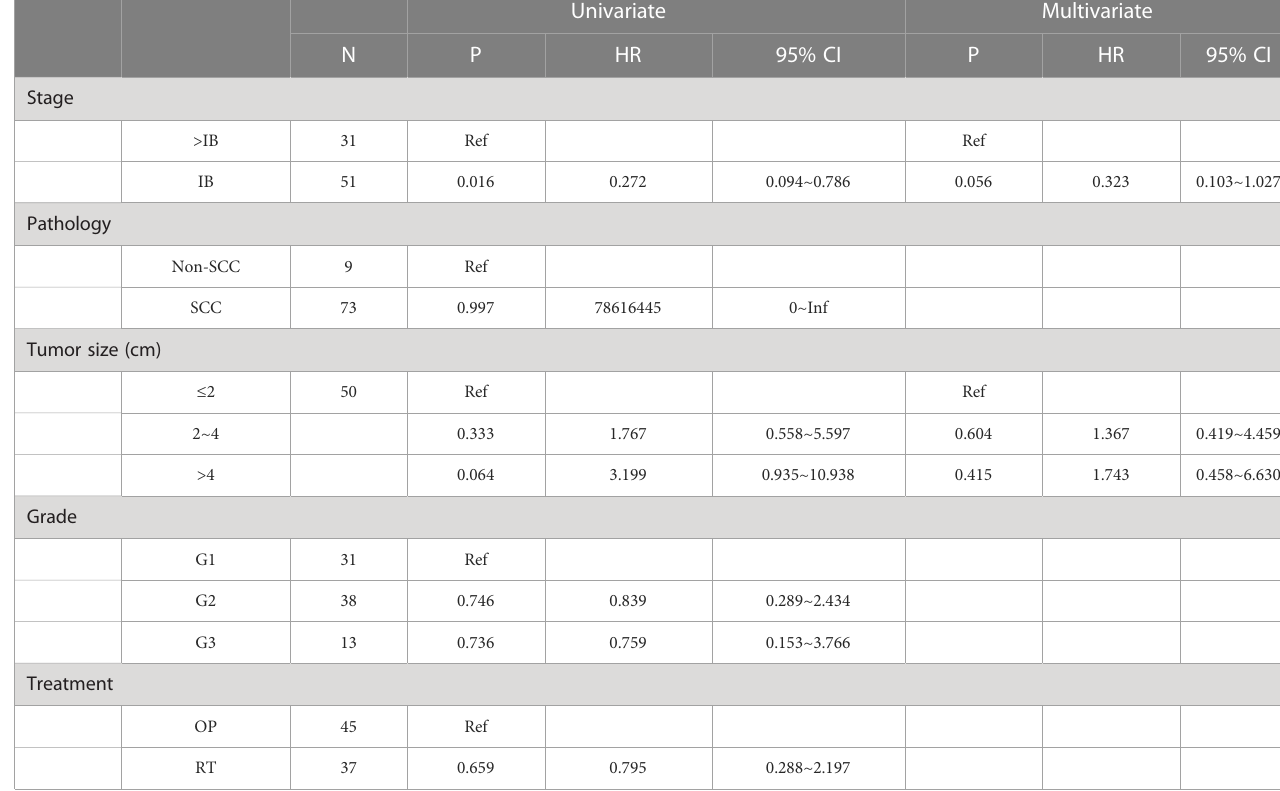
TABLE 3 Univariate and multivariate analyses of PFS in the post-PSM cohort (N =